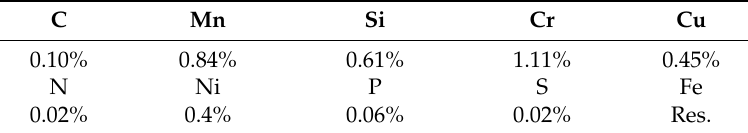
Table 1. Chemical composition of steel S 355J0WP (wt %).